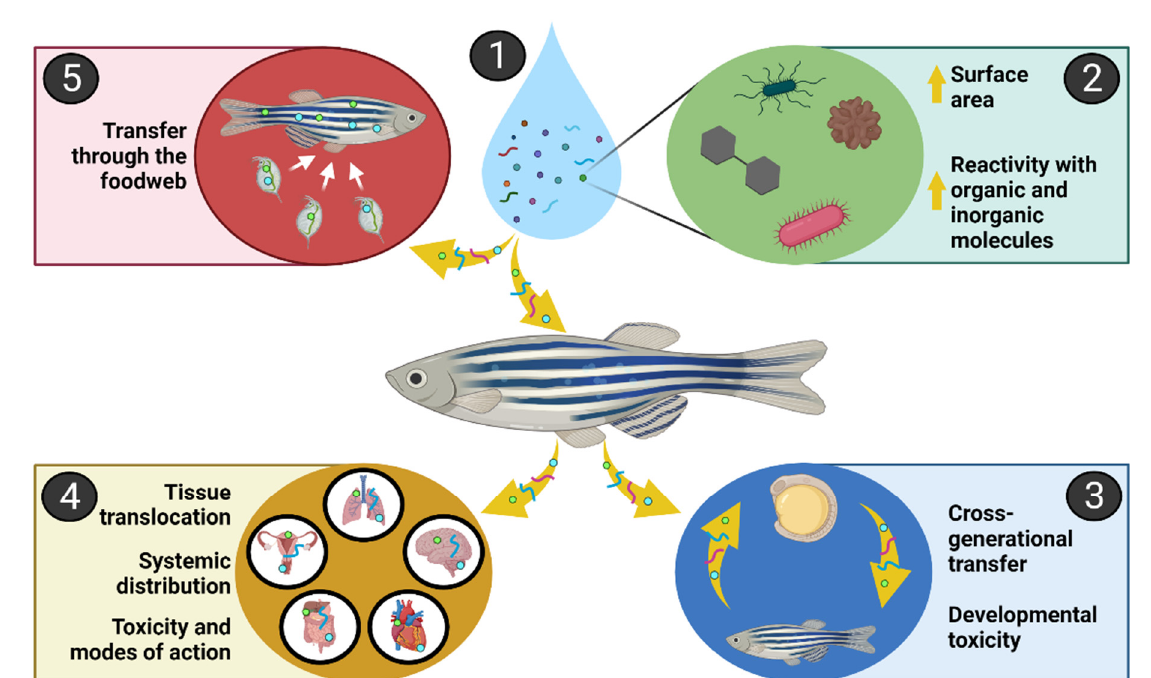
Figure 1. Fate and impacts of nanoplastics (NPs) in aquatic species. ( 1 ) Mixtures of NPs in the aquatic environment; ( 2 ) interactions of NPs with environmental molecules; ( 3 ) impacts of NPs on animal development; ( 4 ) internal distribution and toxicity of NPs; ( 5 ) transfer and potential biomagnification of NPs through the food web. Please see the text for further clarification. Organs in panel 4 are shown as corresponding to mammalian species for purposes of visualization.